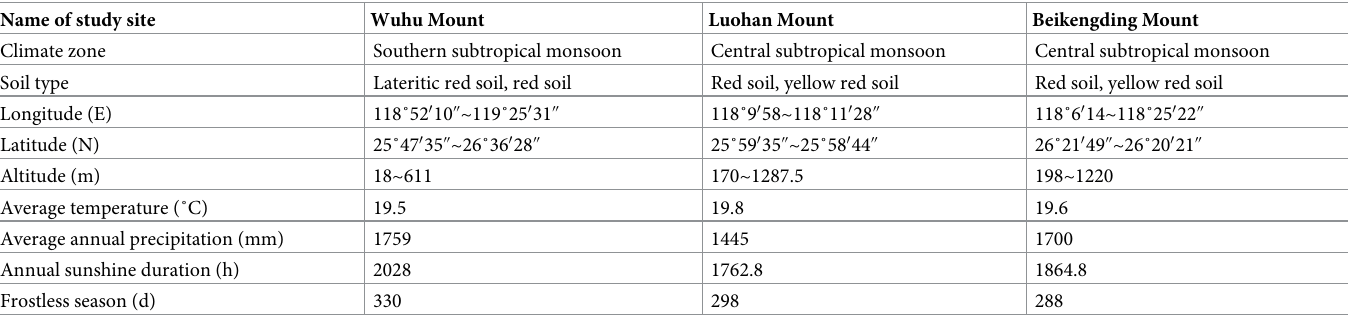
Table 1. Survey of study